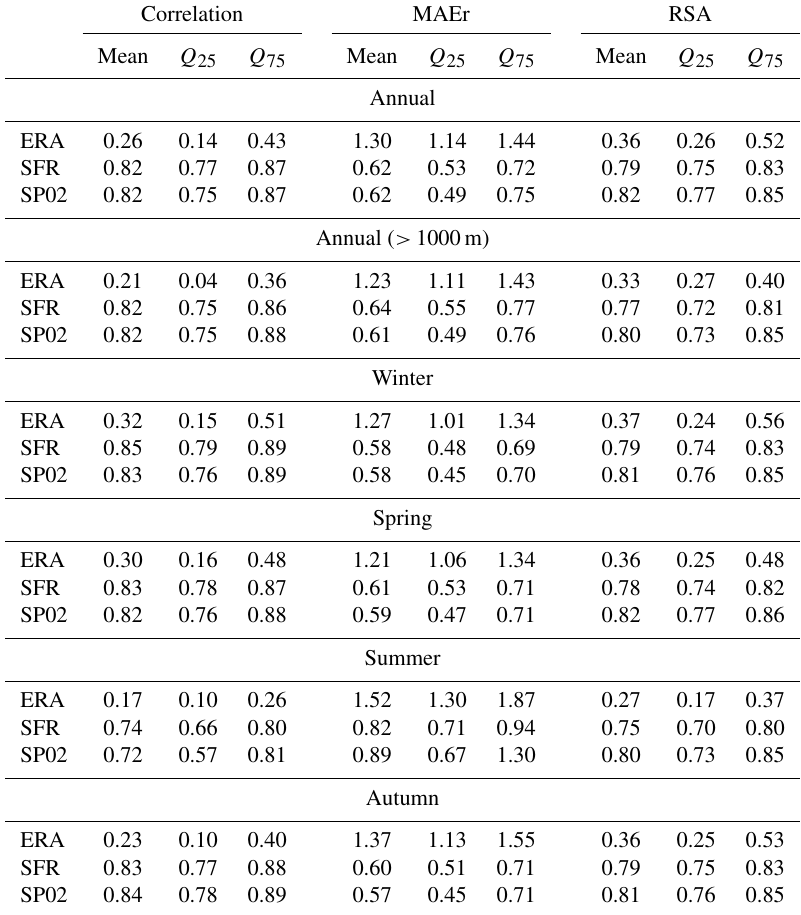
Table 3. The correlation (CORR), relative mean absolute error (MAEr) and ROC skill area (RSA) of the three compared products considering all stations (the upper half of the table) and those located at altitudes higher than 1000m (the lower half of the